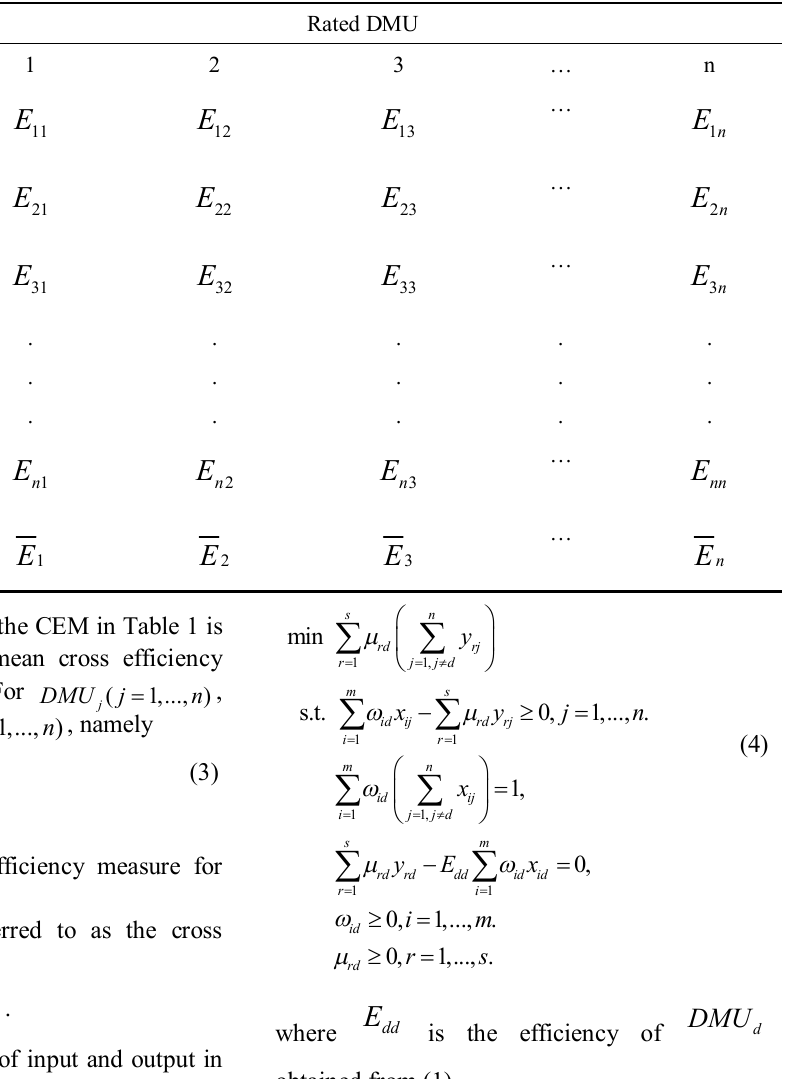
Table 1. A generalized cross efficiency matrix